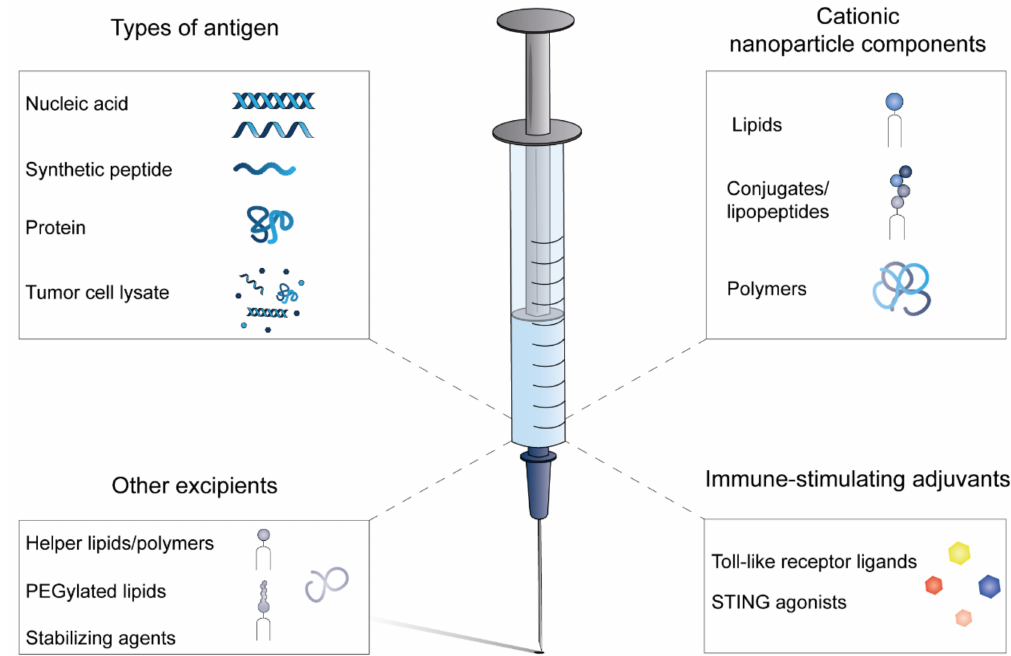
Figure 1. Composition of cationic nanoparticle-based cancer vaccines. Whole-tumor antigens have been incorporated as whole protein or tumor cell lysate in cancer vaccines. Nucleic acids encoding tumor antigens or synthetic peptides can be synthetically manufactured under cGMP conditions. The cationic component of the nanoparticles is often combined with neutral helper lipids and/or polymers to manufacture stable nanoparticles and optimize intracellular antigen delivery by incorporation of fusogenic molecules. In most formulations, additional immune-stimulating adjuvants are included to ensure sufficient APC activation. Stabilizing agents, such as sugars, buffers and surfactants, are included to formulate a stable vaccine that can be stored and